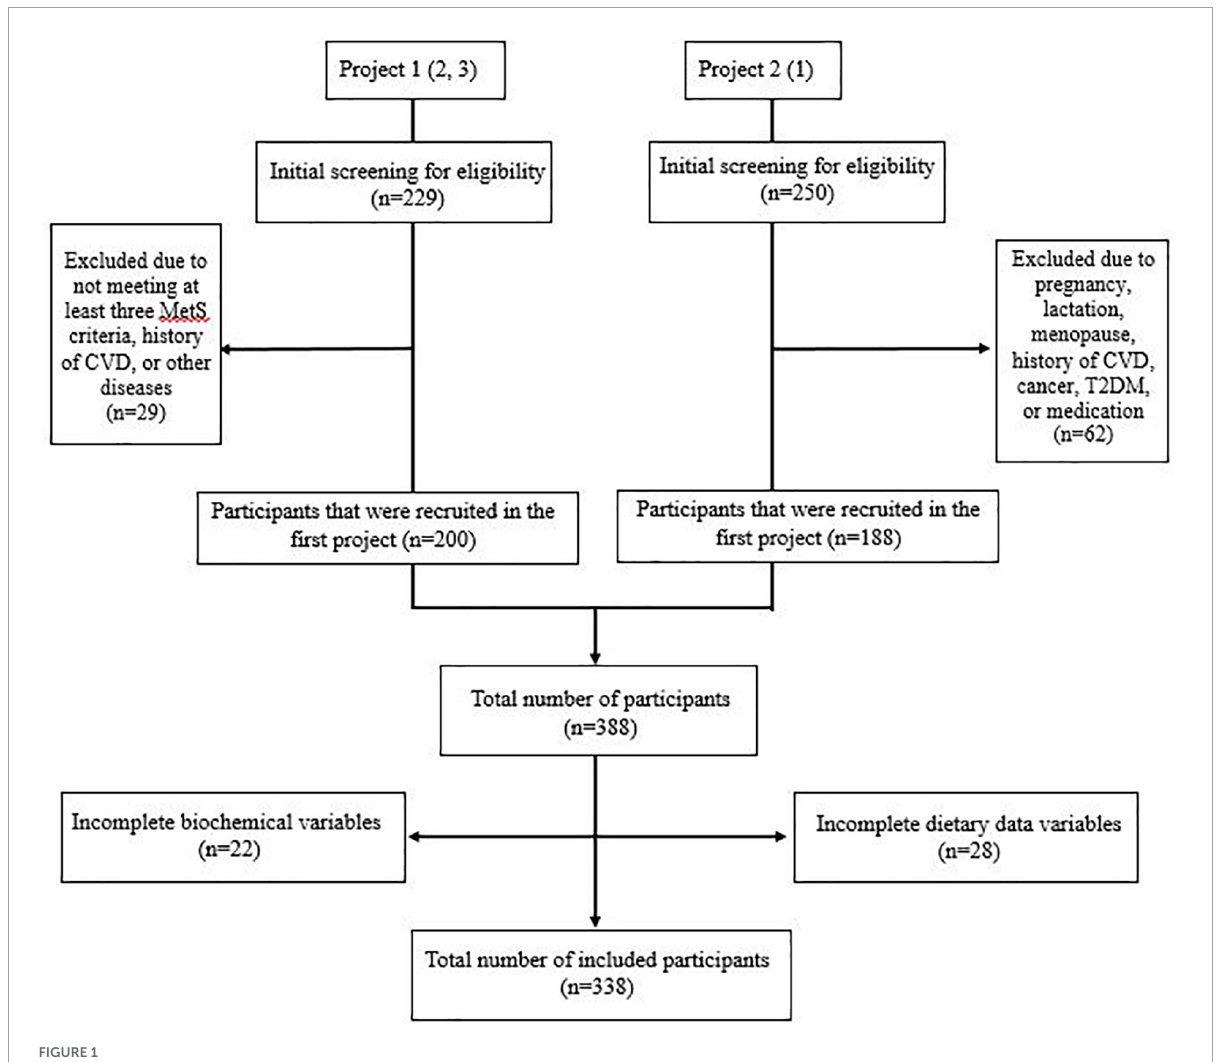
FIGURE1 The study